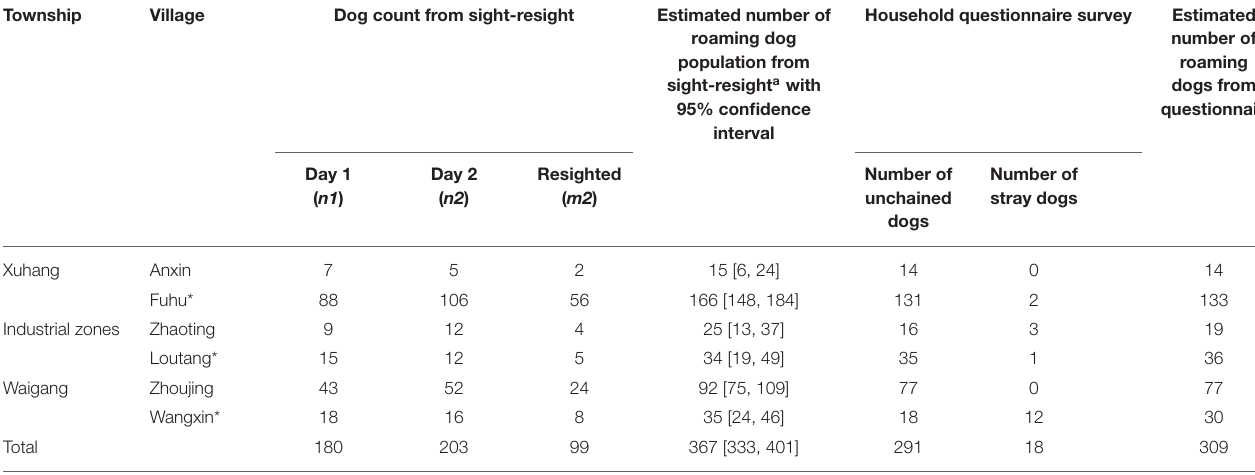
* Non-model village. a Estimated roaming dog population from sight-resight was calculated from the aforementioned formula in the text. Detection probability = m2/n1 = 55%.